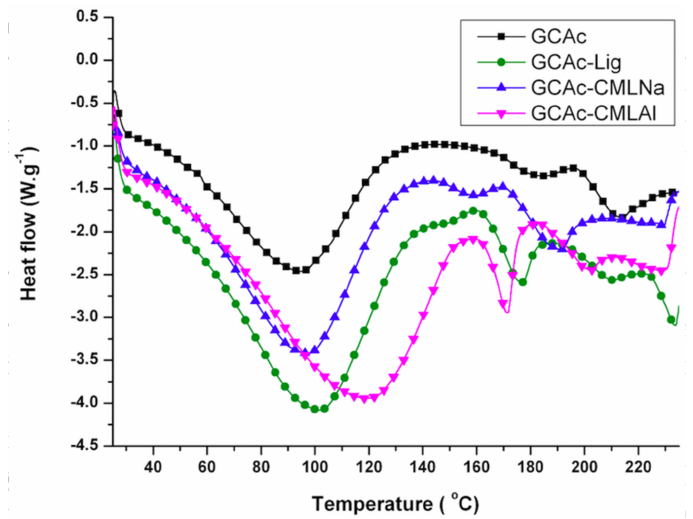
Figure 6. DSC curves for the membranes of group